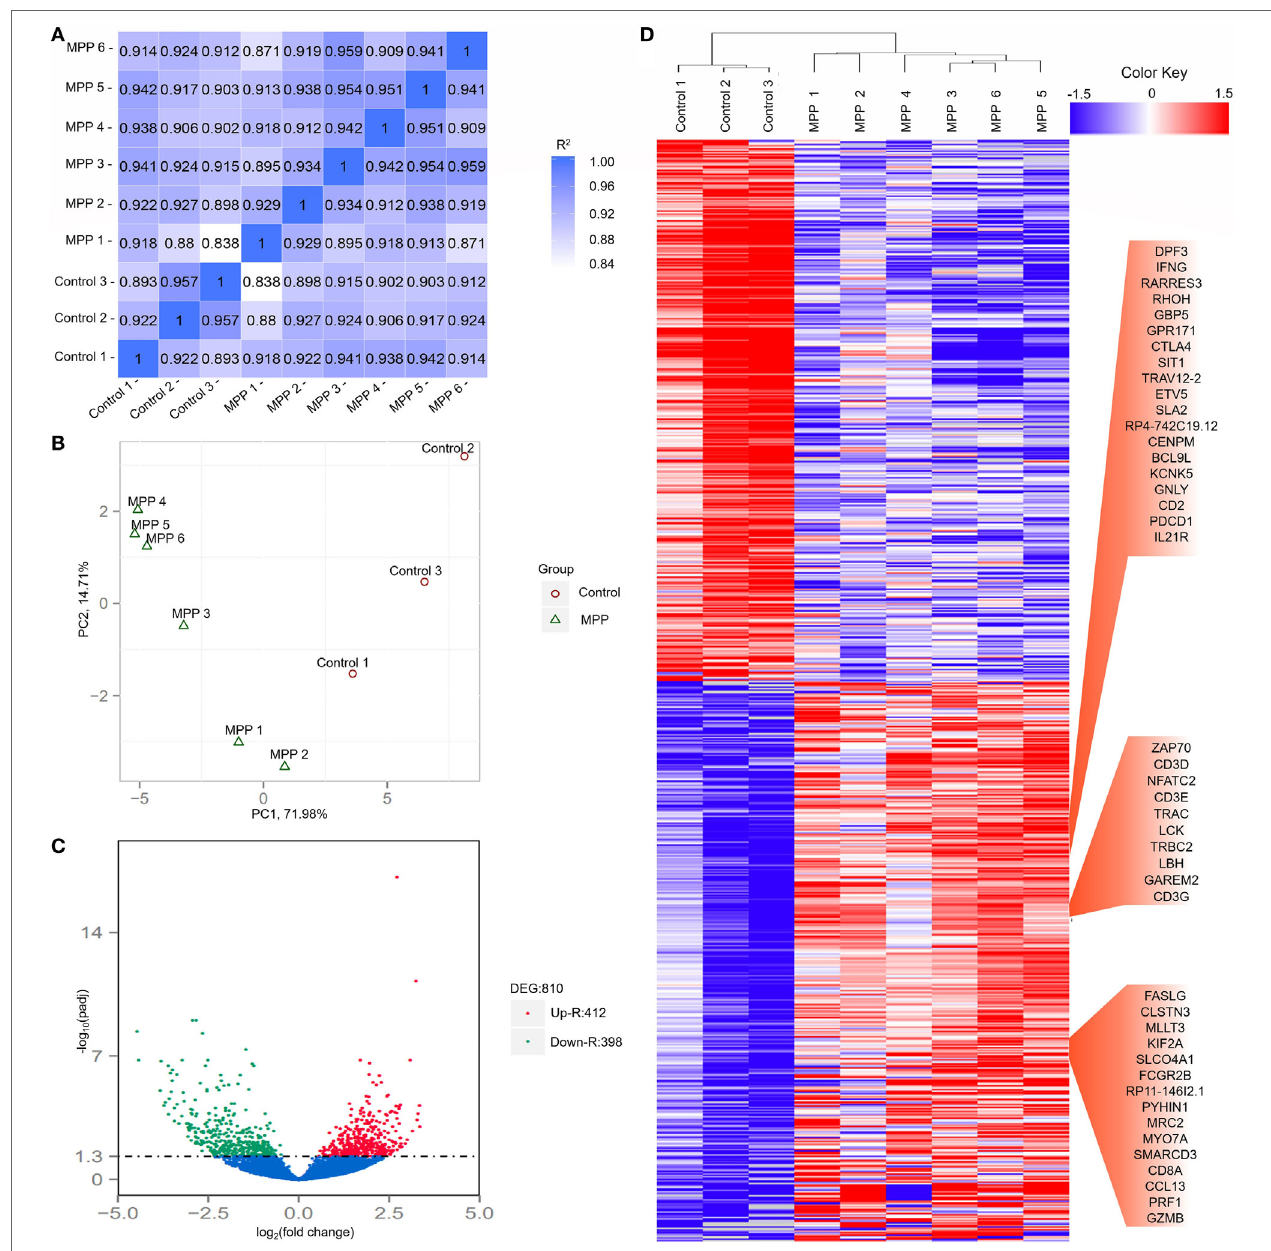
FigUre 2 | Evaluation of each bronchoalveolar lavage fluid sample included in this study and differentially expressed genes between Mycoplasma pneumoniae pneumonia (MPP) group and control group. (a) The correlation coefficient heat map of MPP group and control group. Correlation matrix shows a high consistency of measurements within each group, R 2 ≥ 0.8 is needed for the up-coming analyzing. (B) Principal component analysis (PCA) plot of the sequencing samples. PCA is conducted to evaluate the clustering nature of the samples. The repeatability of the samples has been shown. Each point represents one sample, the red circles represent the samples in the MPP group, and the green triangles represent the samples in the control group. Percentages are contribution ratios. (c) Volcano plot of genes differentially expressed between MPP group and control group. Each point represents one gene that is detectable in both groups. The red points represent the significantly upregulated (Up-R) genes; the green points represent the significantly downregulated (Down-R) genes. (D) Cluster of 810 genes showing significantly regulated genes between MPP group and control group. All of the genes that are differentially expressed between MPP group and control group by adjusted p value < 0.05 have been